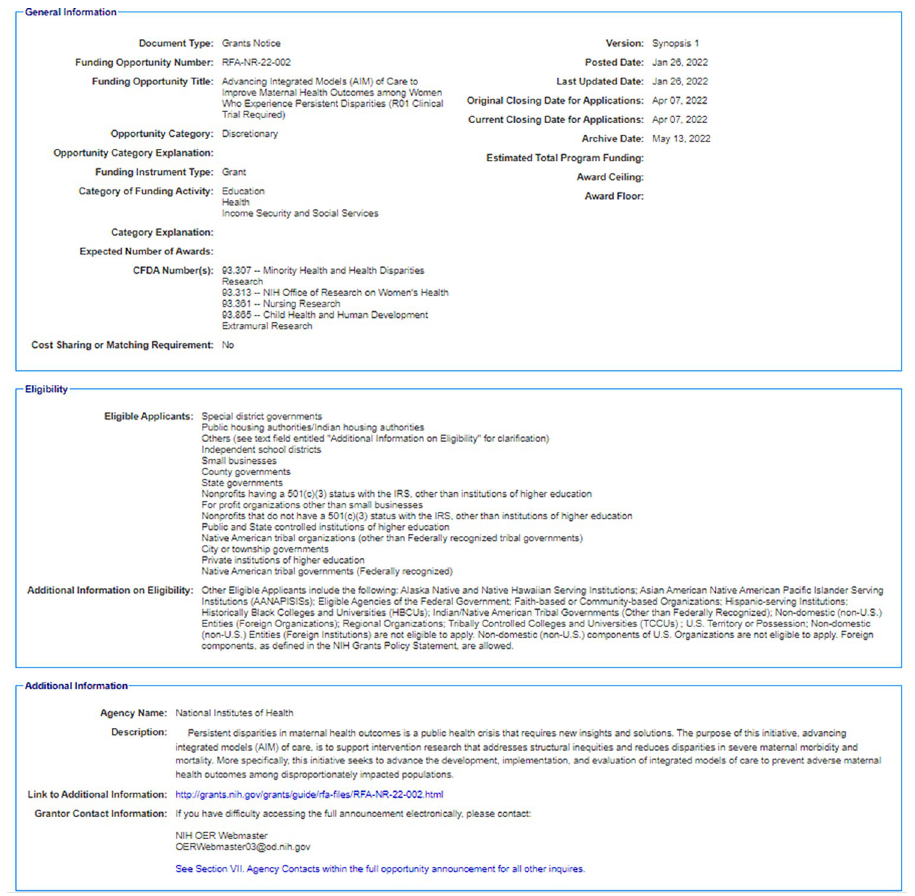
Fig 3. An example of grant details